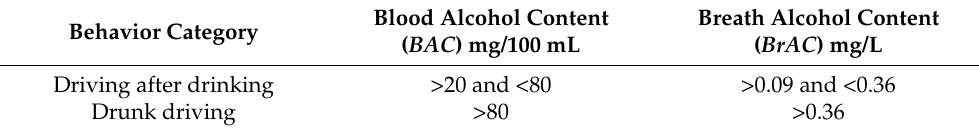
Table 1. Standard alcohol content for driving after drinking and drunk driving.